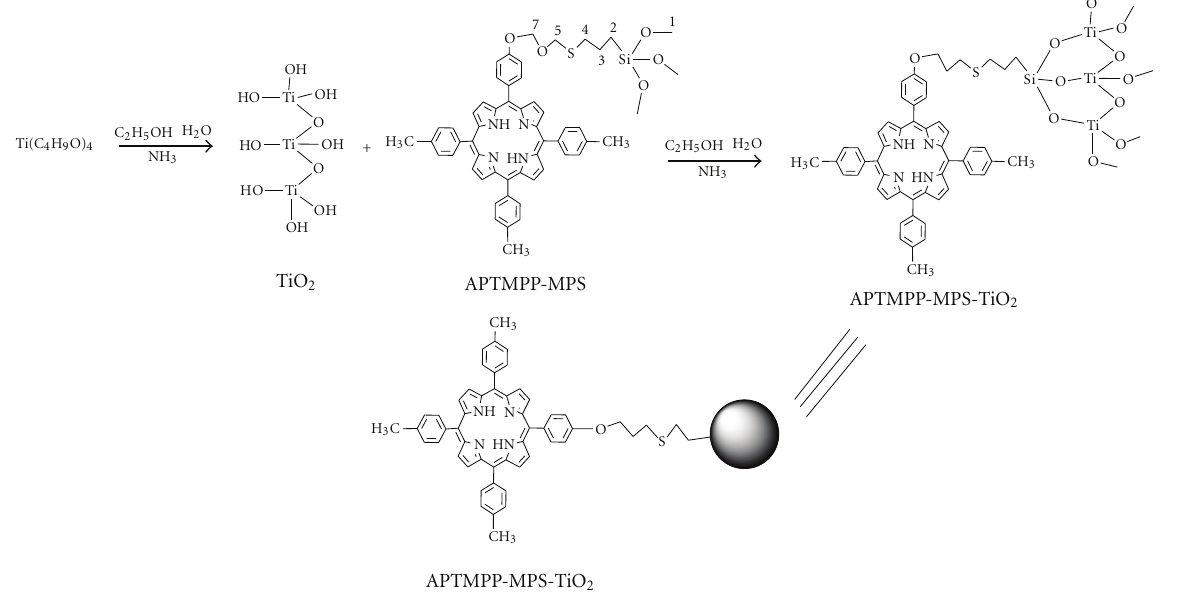
Scheme 1: Synthesis route of APTMPP-MPS-TiO 2